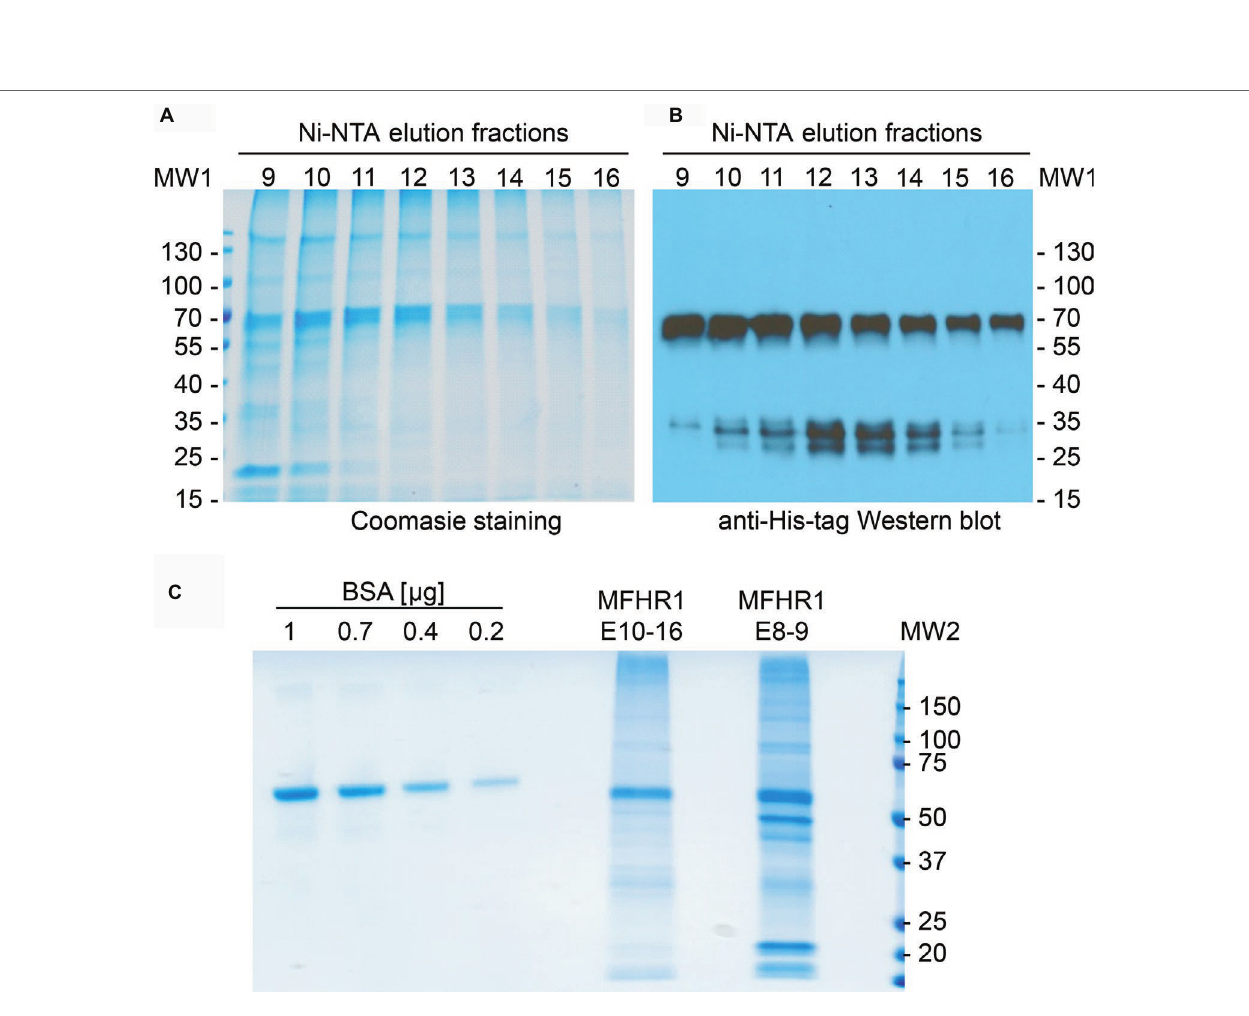
FIGURE 3 | Purification of mossMFHR1. (A) Coomassie staining of MFHR1 elution fractions 8-13, purified via Ni-NTA chromatography. (B) Western blot of the same elution fractions detected with anti-His-tag antibodies. MW1: PageRuler Prestained Protein Ladder (Thermo Fisher Scientific). (C) Coomassie staining of MFHR1 elution fraction pools (E8-9 and E10-16) and BSA as a reference. MW2: Precision Plus Protein™ Standard (BioRad).